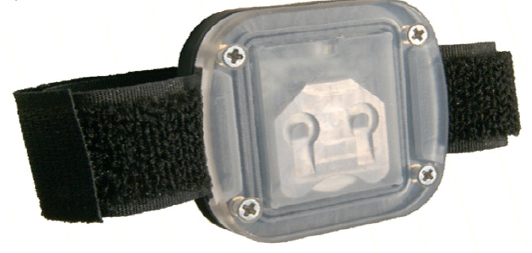
Figure 1. Actimeter ‘Daqtometer v2.4 ′ (Daqtix, Germany).